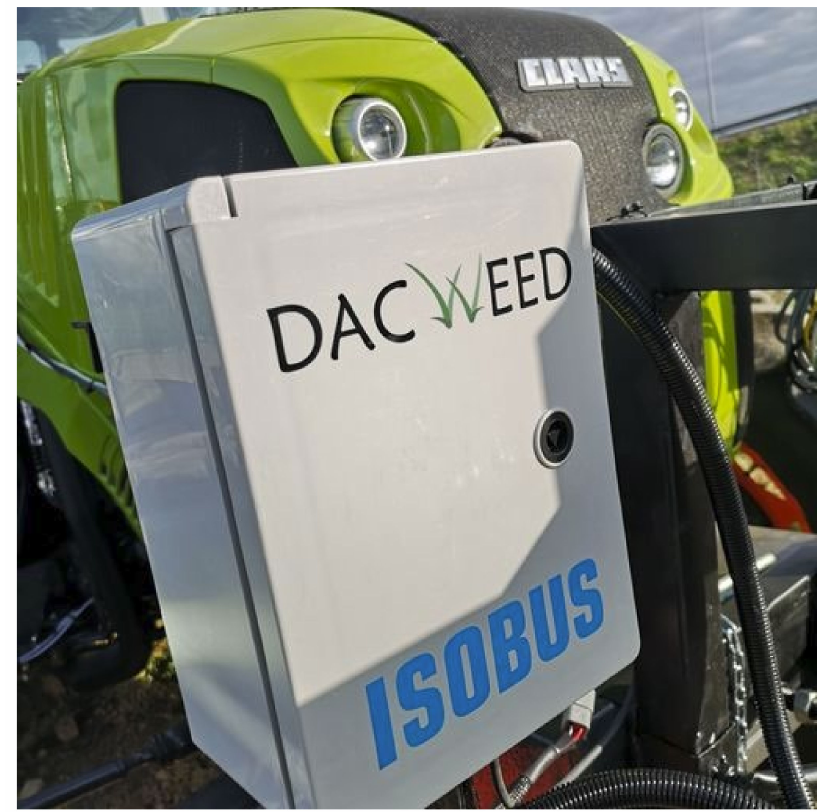
Figure 6. Setting of the project DACWEED source: DACWEED.